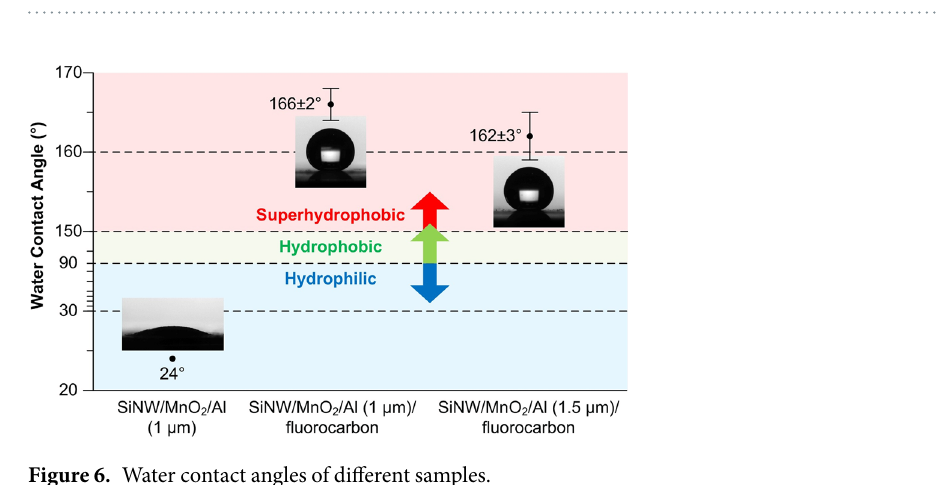
a spin energy separation of 11.7 eV between Mn 2p 1/2 and Mn 2p 3/2 peaks are consistent with those in MnO 2 34 . Besides, a peak energy separation of 4.9 eV is observed from the high-resolution spectrum of Mn 3 s as shown in Fig. 5e, which is in agreement with the manganese oxidation state at 4 35 , indicating that MnO 2 layer is successfully formed on the surface of Si wire arrays because of the decomposition of KMnO 4 in water as 36 + = ↓ + + ↑ . KMnO H O MnO Moreover, Mn peaks disappear in the survey spectrum of Si-W/MnO 2 /Al as shown in Fig. 5b, and instead, Al 2 s and Al 2p peaks show up, demonstrating Si-W/MnO 2 arrays are fully covered by the deposited Al layer at the surface. The high-resolution XPS spectrum of Al 2p shown in Supplementary Fig. S2 demonstrates the existence of Al and alumina, where the oxide can be attributed to the natural oxidation in air before testing. Supplementary Fig. S3 shows the XPS survey scan spectrum of the Si wire arrays and the high-resolution spectra of C 1 s and Si 2p. Figure 5c shows the survey scan XPS spectrum of Si-W/MnO 2 /Al/fluorocarbon. The C 1 s, F 1 s, and F KLL Auger electron signals indicate the main elements within the outer layer are C and F. The C 1 s high-resolution XPS spectrum of the fluorocarbon thin film shown in Supplementary Fig. S4 demonstrates the existence of C-F 3 (293.1 eV), C-F 2 (291.3 eV), C-F (289.3 eV), and C-CF n (287.1 eV) 37, 38 , with a calculated concentration percentage of 30.9%, 33.5%, 21.6%, and 14.0%, respectively. Beside the lowest surface free energy provided by CF 3 groups that could result in a hydrophobic or even superhydrophobic surface 39 , the higher concentrations of CF 2 and CF 3 can be beneficial for energetic applications from the chemical reaction point of view 32 .